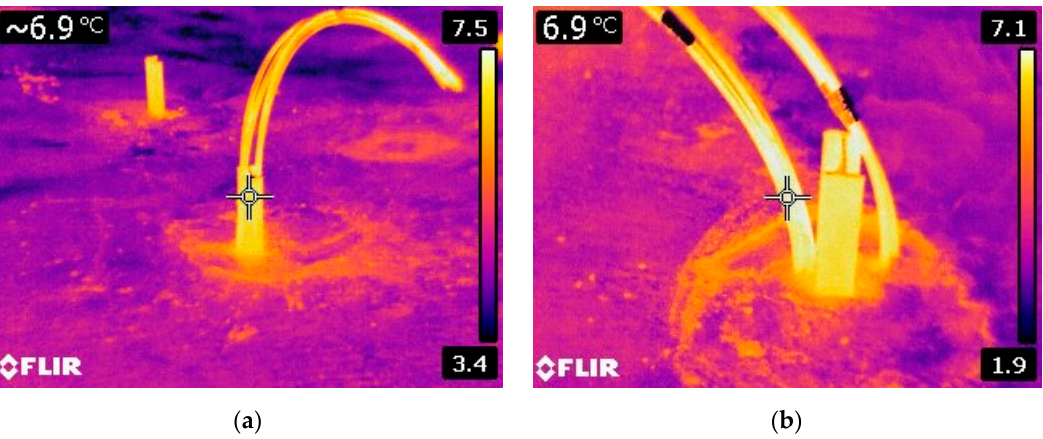
Figure 8. ( a ) and ( b ) examples of individual energy piles at the construction site of the National Archives in Krakow (a thermal image).